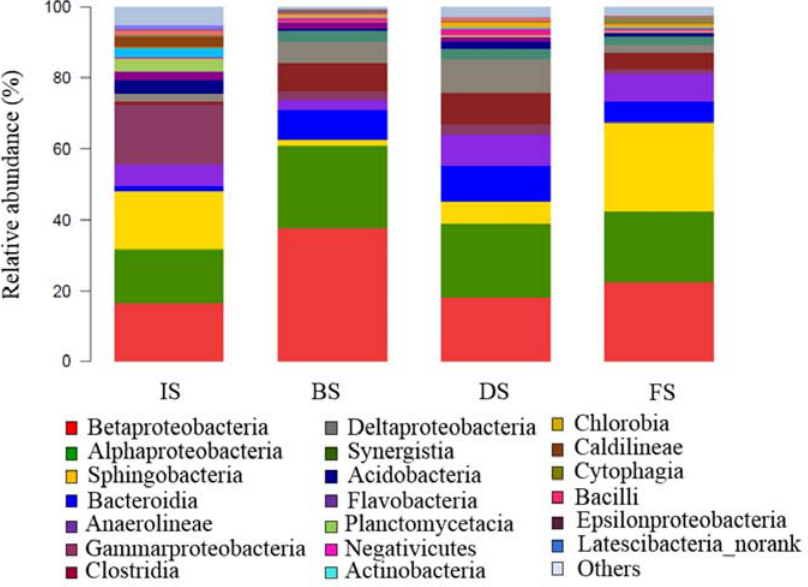
Figure 8. Microbial community structure and composition, by class, in samples from the MLCOP